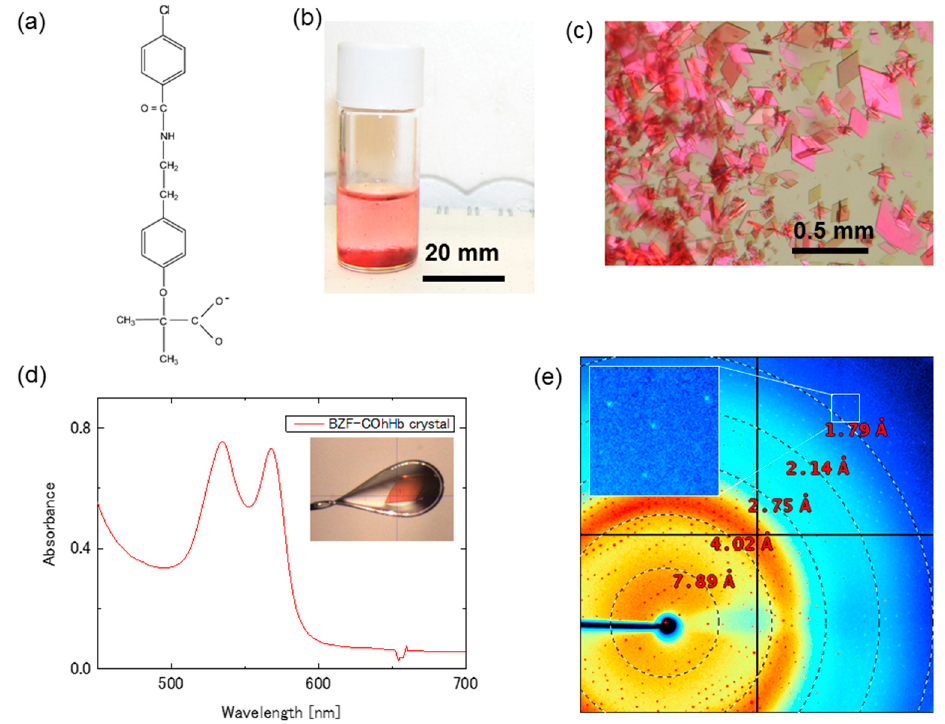
Figure 3. High quality, very thin R-state Bezafibrate-Bound Horse COHb (BZF-COhHb) crystals for XRC combined with CO photolysis and/or spectrophotometry. ( a ) The allosteric effector, bezafibrate (BZF); ( b ) Batch samples at 5 days after the crystallization setup; ( c ) Very thin BZF-COhHb crystals under polarized light; ( d ) Typical absorption spectrum of the BZF-COhHb crystal at 100 K. Inset shows a photograph of the measured crystal; and, ( e ) An X-ray diffraction pattern of the same COHbC crystal as used for the spectral measurement. Diffraction spots are visible at least to 1.7 Å.